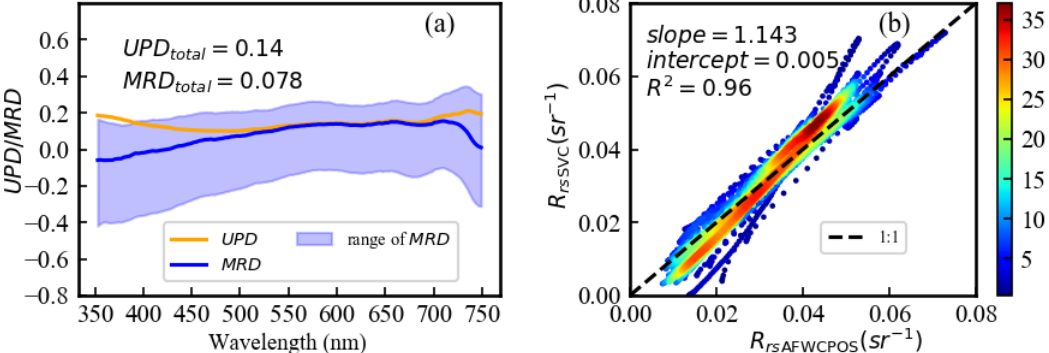
Figure 9. ( a ) The UPD (unbiased percent difference) and MRD (mean relative difference) as a function of wavelength for R rsSVC and R rsAFWCPOS . ( b ) Comparison of R rs dataset from the AFWCPOS ( R rsAFWCPOS ( λ )) and simultaneous manual measurements ( R rsSVC ( λ )) provided by an SVC HR-1024 field-portable spectroradiometer at Poyang Lake.